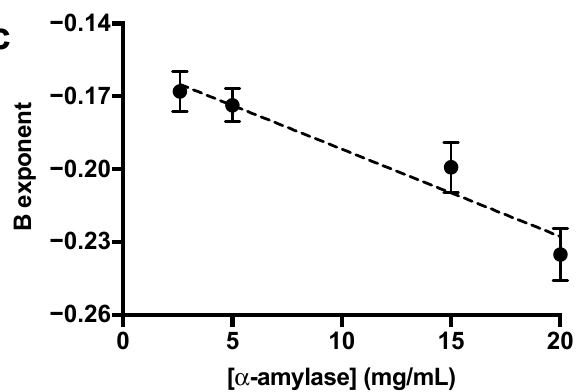
Figure 2. Mechanical changes of chia mucilage suspensions as a function of α -amylase concentration, showing normalized storage modulus G’ ( a ), loss tangent trend over time for each chia- α -amylase mixture ( b ), and exponent b ( 𝑦 = 𝑎𝑥 (cid:3029) ) linear dependance on α -amylase concentration ( c ). Table 1. Values of a and b coefficients ( 𝑦 = 𝑎𝑥 (cid:3029) ) for each α -amylase concentration used.